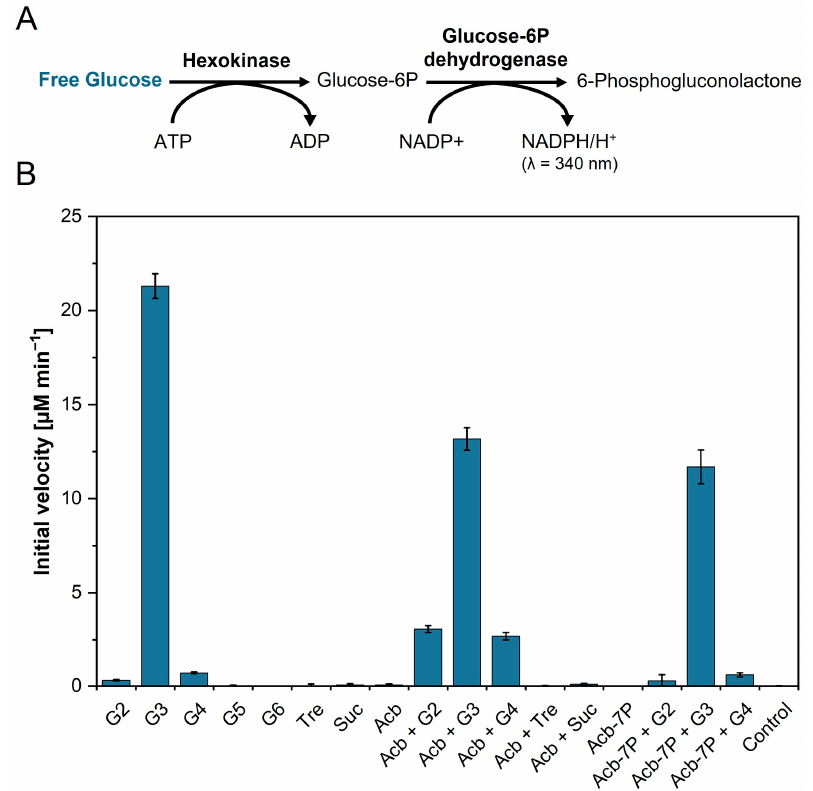
Figure 3. Biochemical characterization of substrate preference of AcbQ. ( A ) Spectrophotometric cou- pled enzyme reaction with a hexokinase and glucose-6-phosphate dehydrogenase to detect the for- mation of glucose. ( B ) Initial velocity of AcbQ with di ff erent substrates. Control reaction was per- formed with inactivated AcbQ ( n = 3). performed with inactivated AcbQ ( n =